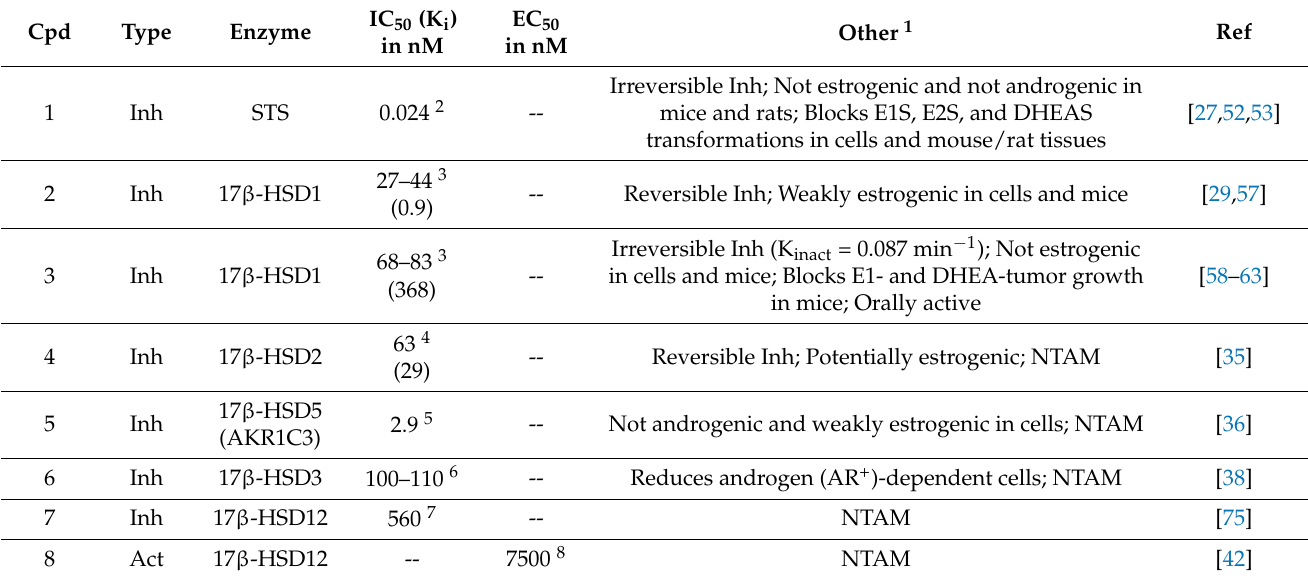
Table 3. Summary of biological activities for compounds 1 – 8